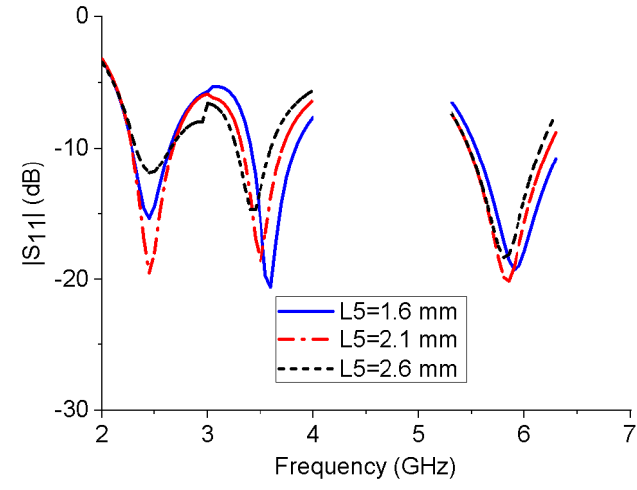
Figure 5. Reflection coefficients of the monopole antenna with different L5 values.